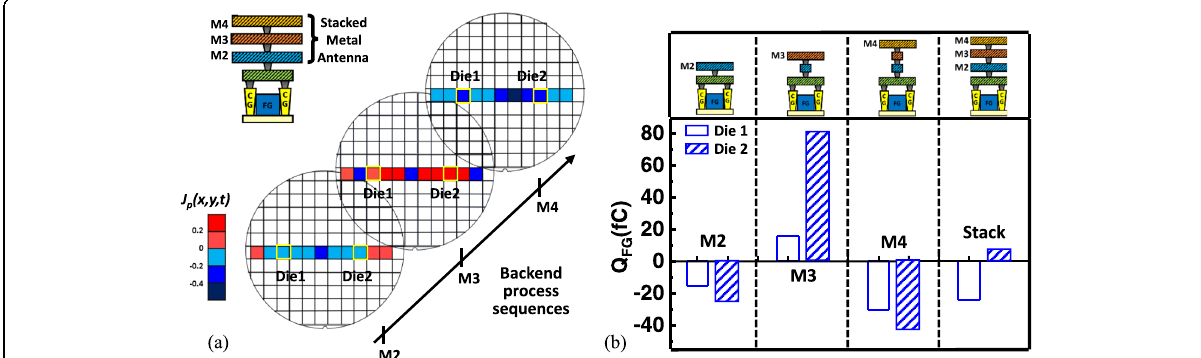
Fig. 3 a The plasma charging effect for the different metal layers varies on different locations across the wafer. b The positive and negative charges may compensate each other in the stacked metal